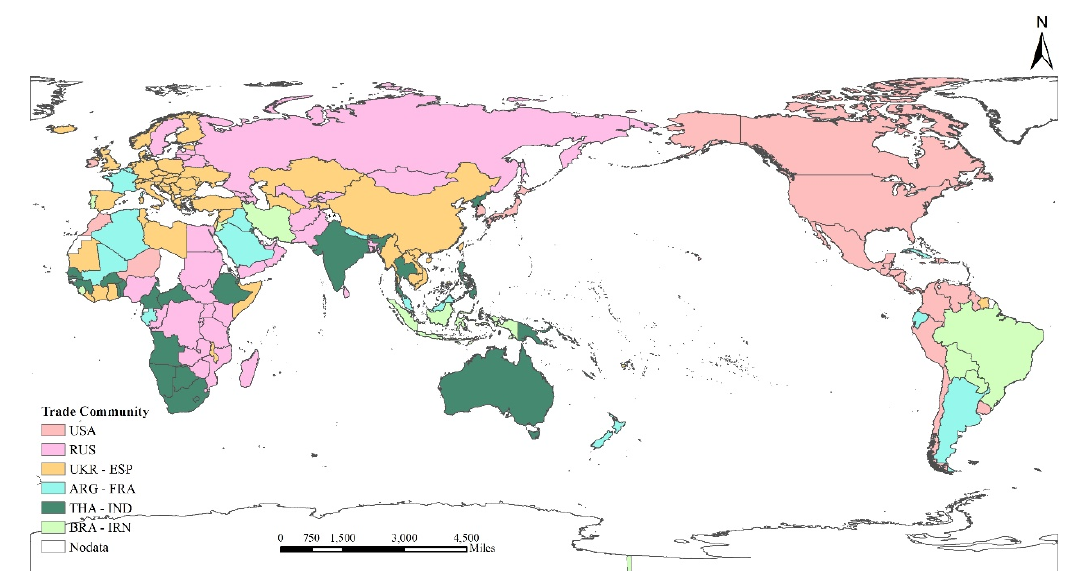
Figure 6. Spatial distribution of global FTN communities in 2018. The same color indicates the same trade community.